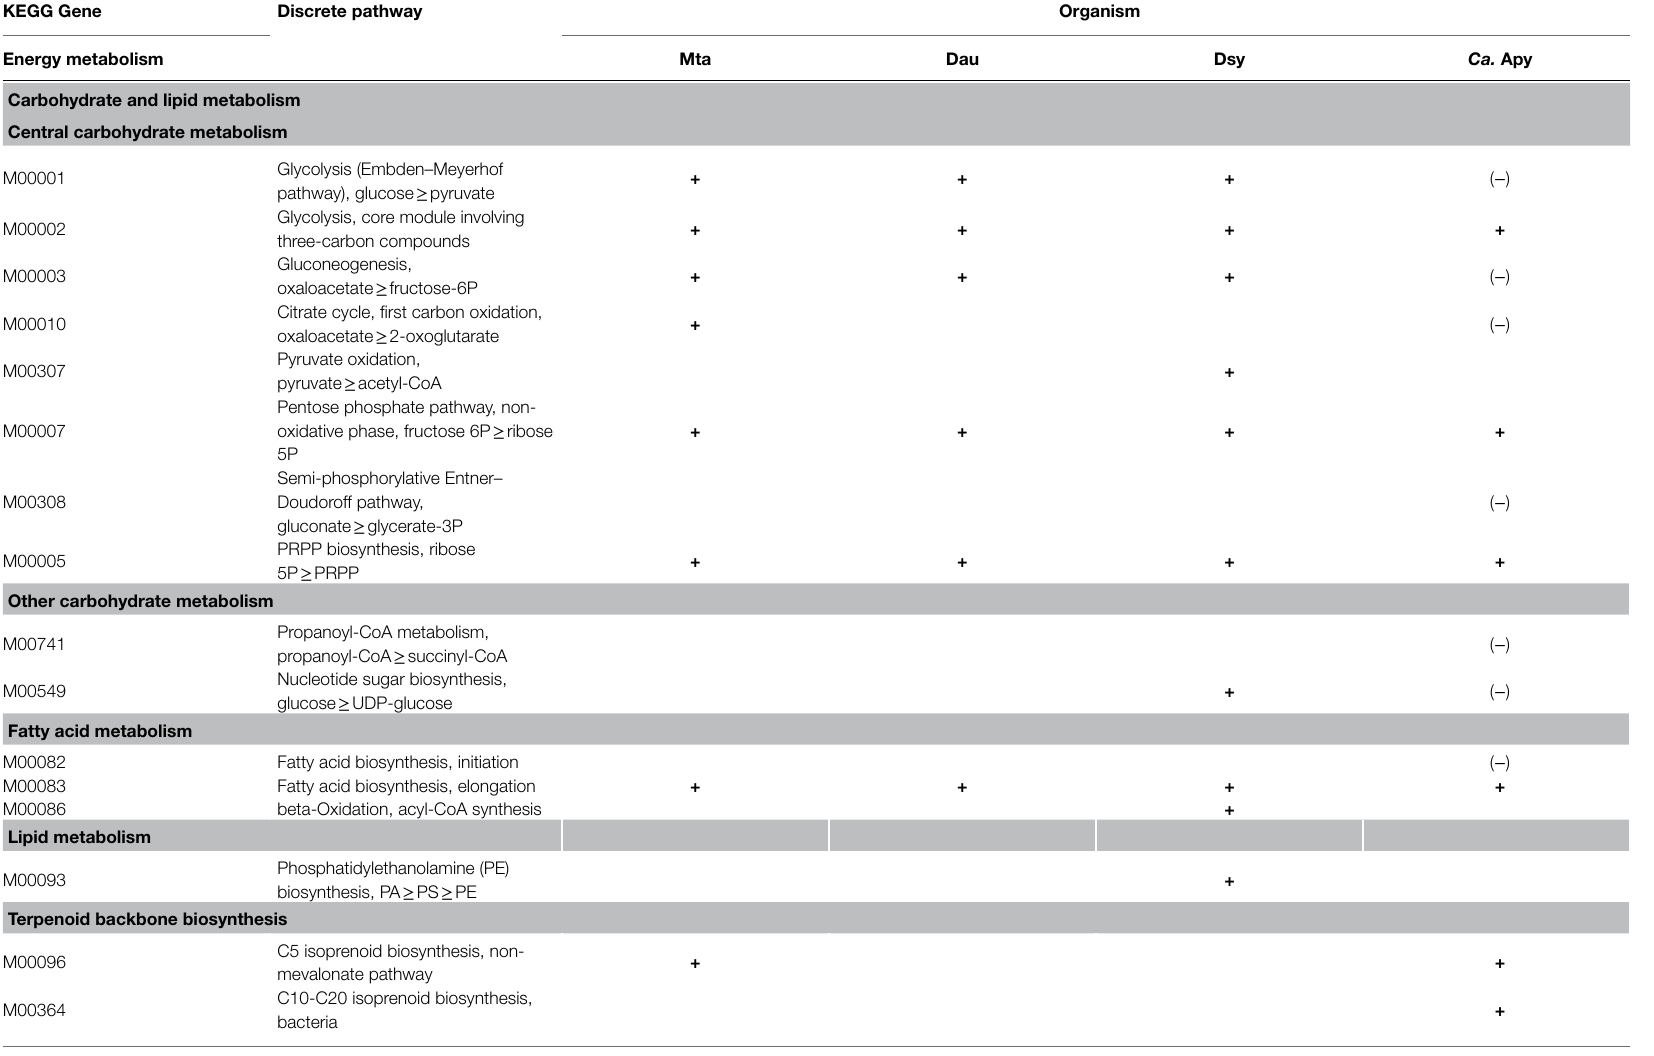
TABLE 3 | Complete pathways of carbohydrate and lipid metabolism in Ca. A. pyornia ( Ca. Apy) and two closely related acetogens as determined by the KEGG pathway module. KEGG Gene Discrete pathway Organism Energy metabolism Mta Dau Dsy Ca. Apy Carbohydrate and lipid metabolism Central carbohydrate